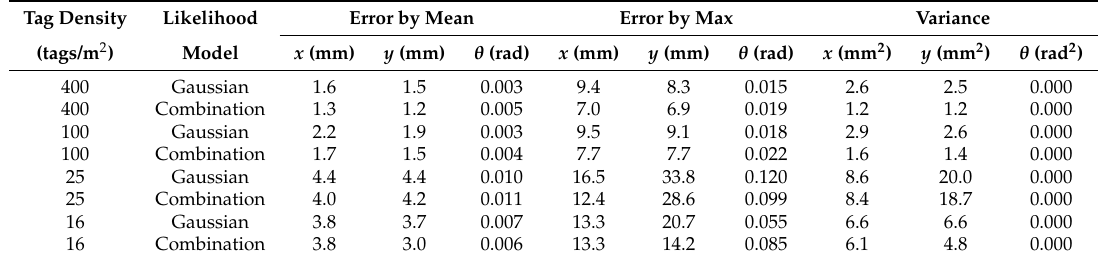
Self-localization performances of the 96 HF-band RFID reader system using two likelihood